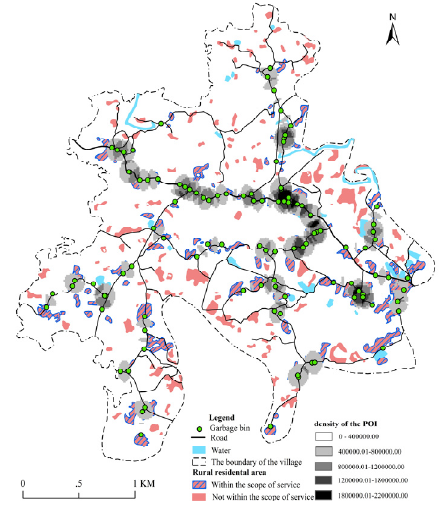
Figure 4. Spatial layout rationality of garbage bins in Yuding Village.